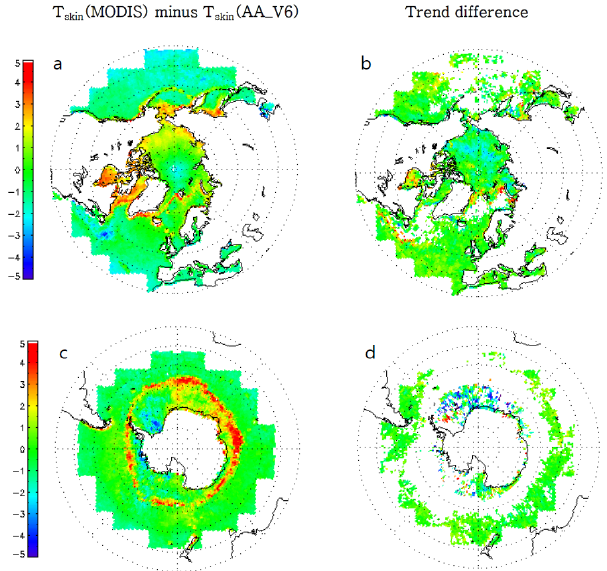
Figure 10. (a) 12-year mean of T skin (MODIS) minus T skin (AA_V6) (K) over the Northern Hemisphere during 16–24 April 2003–2014, and (b) difference in the thermal trend (Kdecade − 1 ) between T skin (MODIS) and T skin (AA_V6). (c) – (d) are the same as (a) – (b) except for over the Southern Hemisphere during 16– 24 September 2003–2014, respectively. (a) is the same as Fig. 3a in Kang and Yoo (2015).